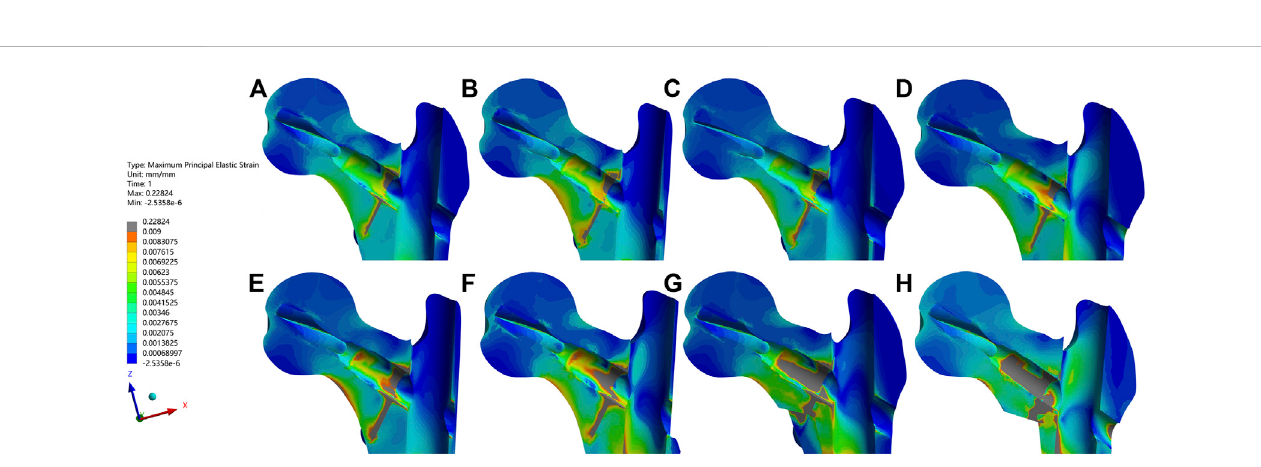
FIGURE 7 Themaximumprincipalstrainandnephograms oftheproximalfracturemodelsunderthedynamicclimbinghipcontactloadswereexhibited.Theorder wasthesameasitwasinFigure4.Fromimages (A – H) ,thepeakvalueofeachbonemodelgraduallyincreasedandthehighestoneof0.22824appearedin (H) . The elements with the values above the cut-off of 0.009 were marked in dark gray.